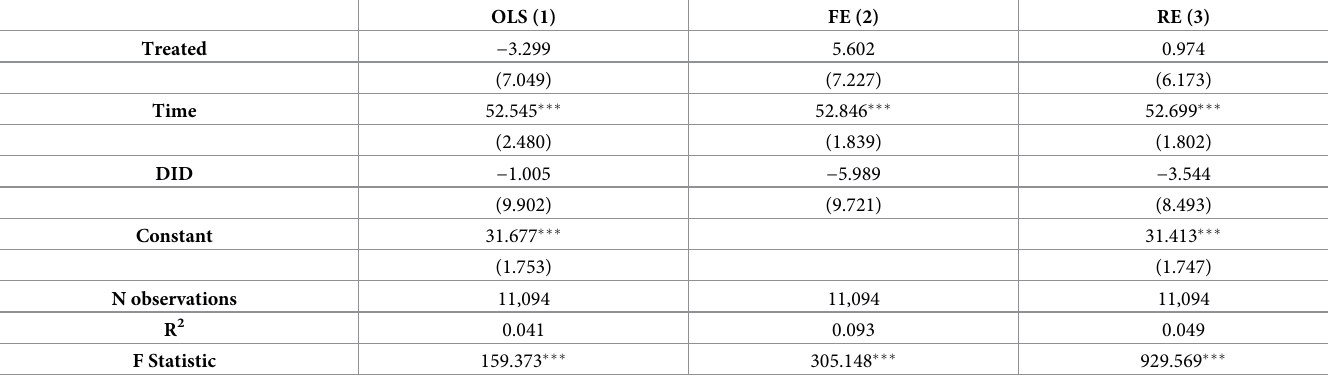
Table 11. Difference-in-differences with PSM weight average agriculture GVA results: Pooling, fixed-effects, and random-effects . OLS